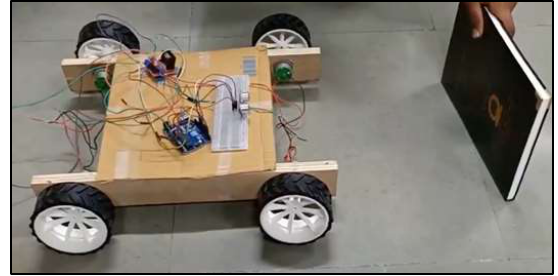
Fig. 15. Obstacle Avoidance Bot Test Run 1 with